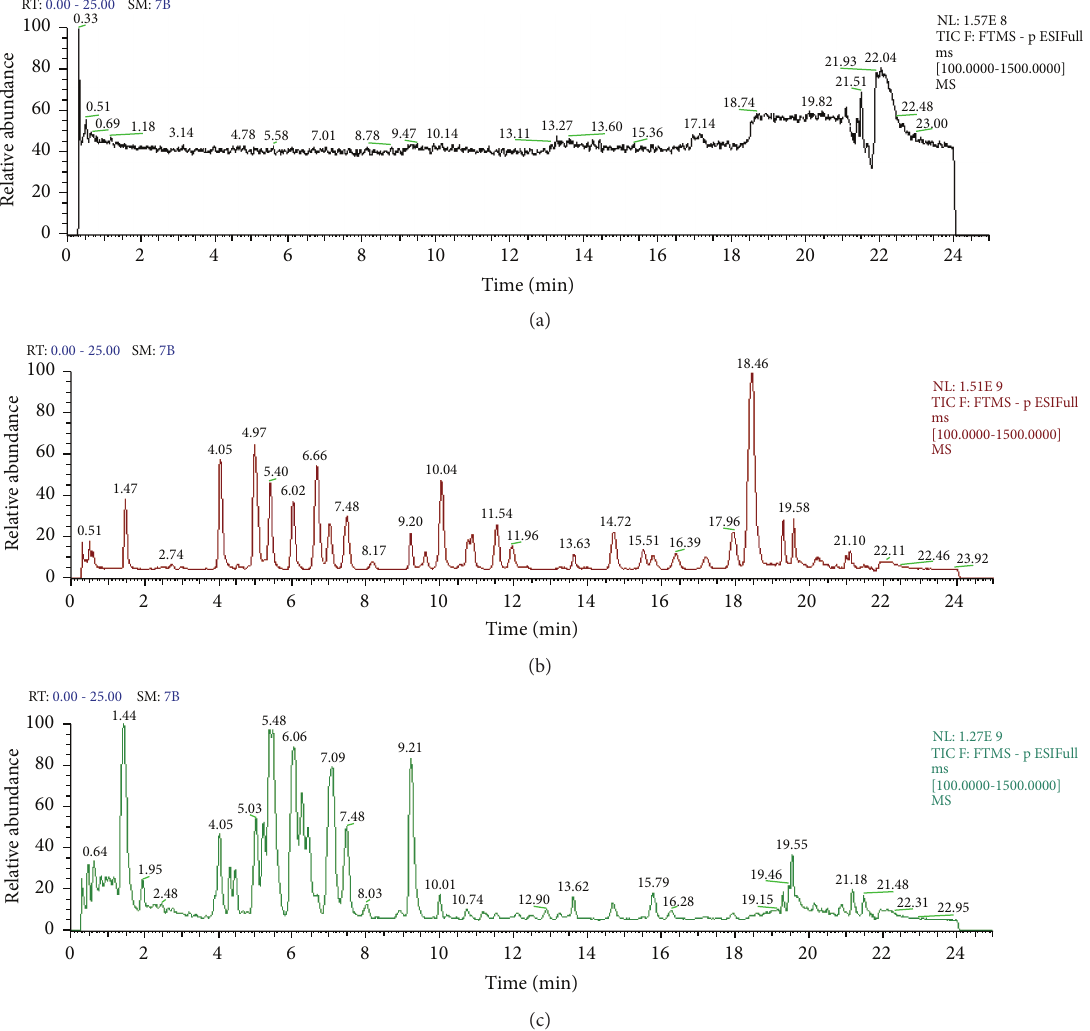
Figure 1: Total ion chromatograms. (a) Blank of methanol, (b) twenty-five ginsenoside standards, and (c) extract of Panax ginseng roots analyzed by UPLC-HRMS in negative ion